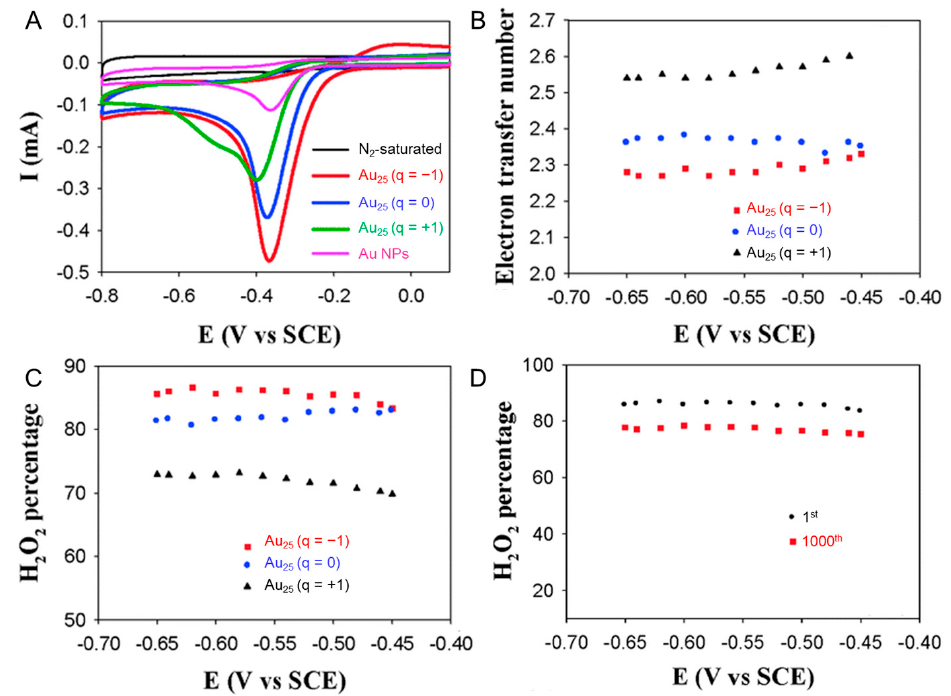
Figure 9. ( A ) Cyclic voltammograms, ( B ) electron transfer number ( n ), and ( C ) percentage of H 2 O 2 of the ORR on Au 25 (SC 12 H 25 ) 18 with di ff erent charge states ([Au 25 (SC 12 H 25 ) 18 ] − , [Au 25 (SC 12 H 25 ) 18 ] 0 , and [Au 25 (SC 12 H 25 ) 18 ] + ) in 0.1 M KOH aq saturated with O 2 . ( D ) Accelerated durability tests of [Au 25 (SC 12 H 25 ) 18 ] − performed for 1000 cycles. Panels ( A – D ) are reproduced with permission from reference [115]. Copyright Royal Society of Chemistry, 2014.